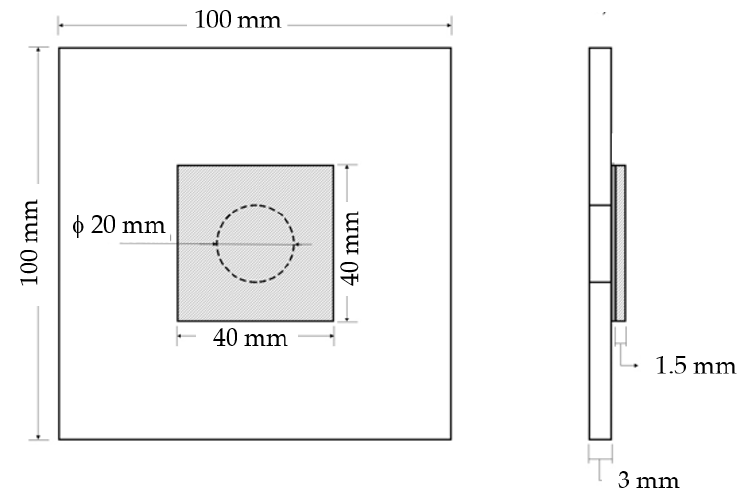
Figure 1. Geometry and dimensions (in mm) of the samples.